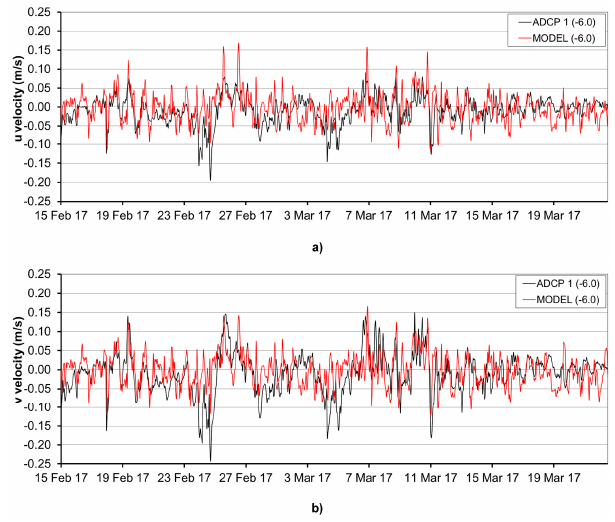
Figure 10. Comparison of measured and modeled hourly averaged ( a ) u velocity component and ( b ) v velocity component at a depth of − 6 m at the position of ADCP 1 for the winter period. Table 4. Normalized root-mean-square error (NRMSE) and Nash-Sutcliffe efficiency index of the measured and modelled velocity values.